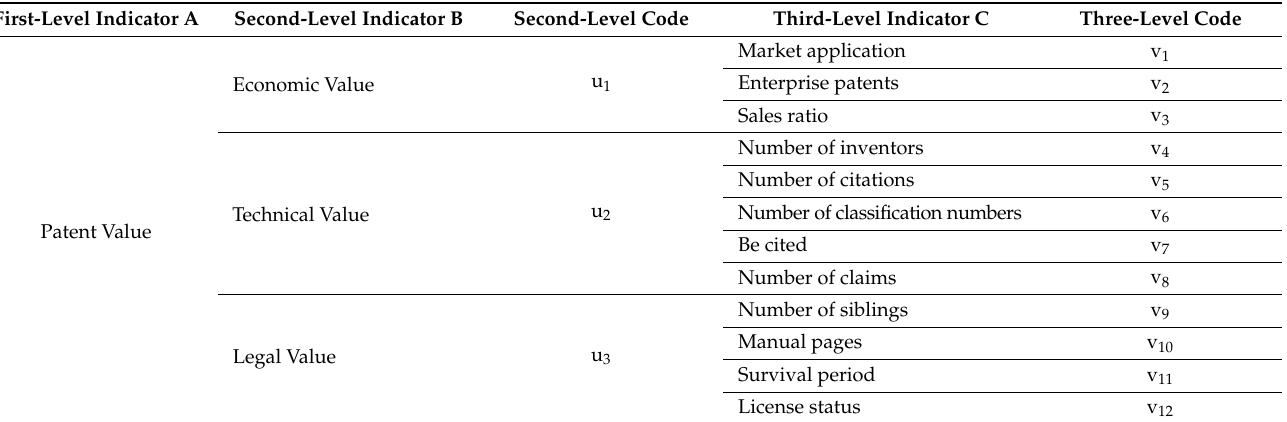
Table 8. Core patent value evaluation